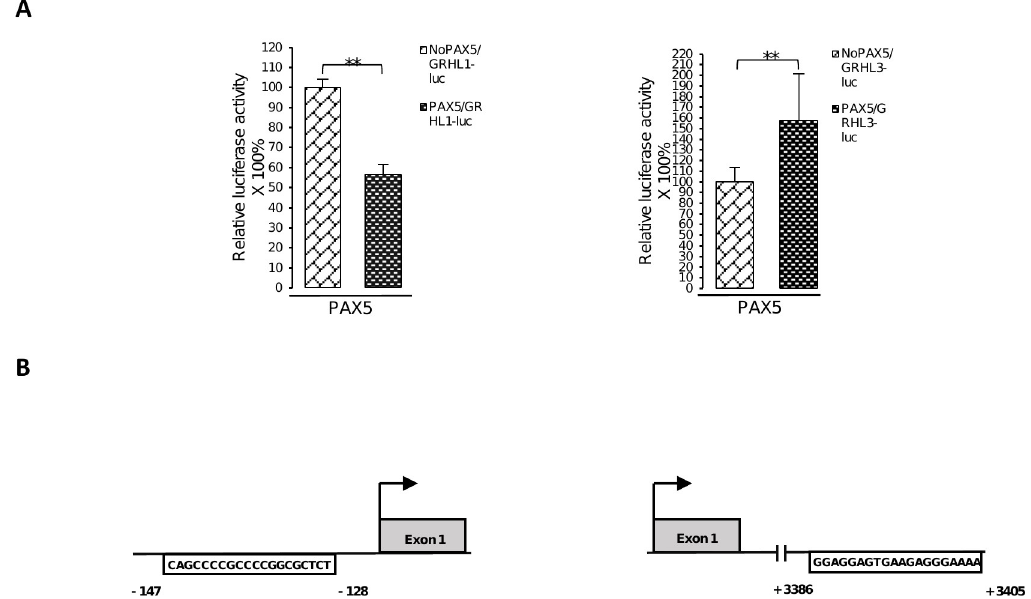
Fig 6. PAX5 changes the activity of GRHL regulatory regions. ( A ) HEK293 cells were transfected with pcDNA3.1-N-DYK-PAX5 plasmid, pGL3-promoter vector containing the luciferase gene under the control of the fragment of the GRHL1 or GRHL3 regulatory sequence with or without binding sites for PAX5 (named: PAX5/GRHL1-luc or PAX5/ GRHL3-luc or NoPAX5/GRHL1-luc or NoPAX5/GRHL3-luc and pRL-CMV Renilla luciferase control reporter vector. Data are shown as means ± SEM of experiments independently performed in triplicate, �� significantly different at p � 0.01. ( B ) Schematic representation of locations of the PAX5 binding site sequences in the promoter of GRHL1 gene and in the enhancer of GRHL3 gene cloned into luciferase